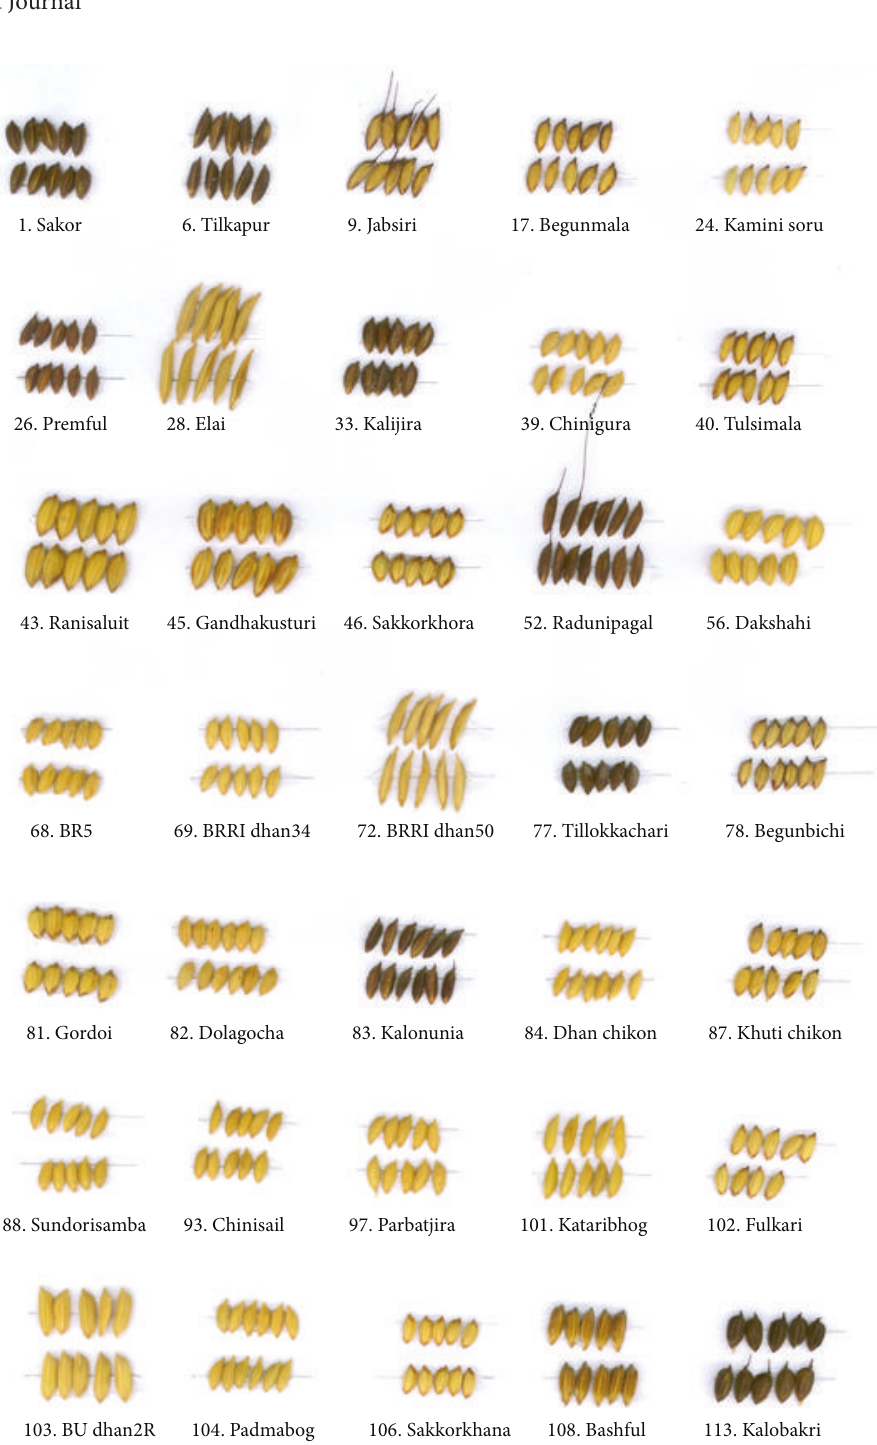
Figure 1: Variation in grain morphology of some aromatic and fine rice